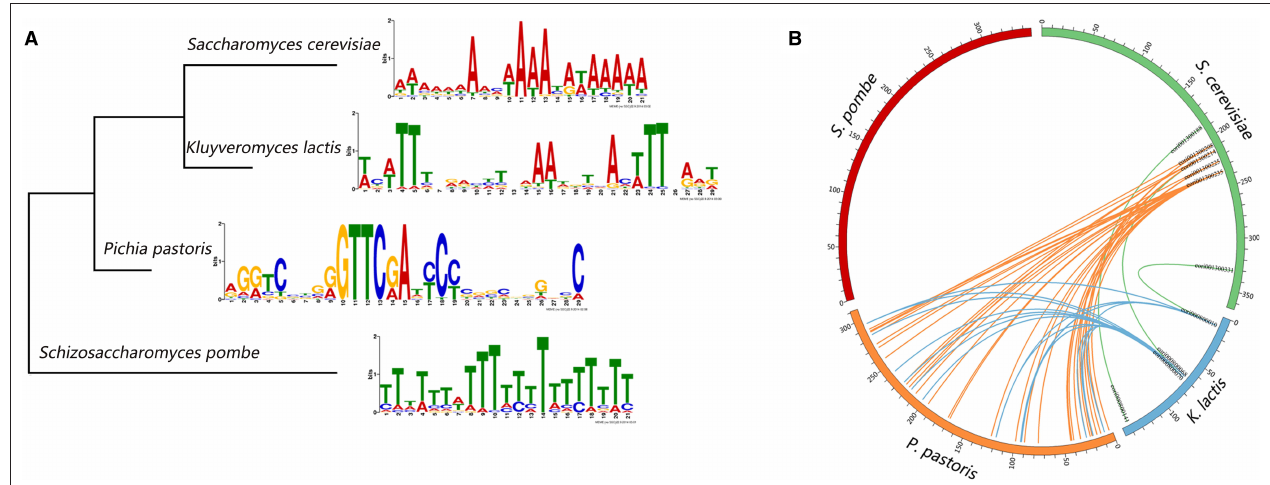
FIGURE 2 | Sequence characteristics of yeast replication origins. (A) The significant motifs found in the replication origin sequences and the phylogenetic tree of the four yeasts. (B) The circos plot of replication origins that share similar sequences. Each number around the circle is the ORI’s serial number in